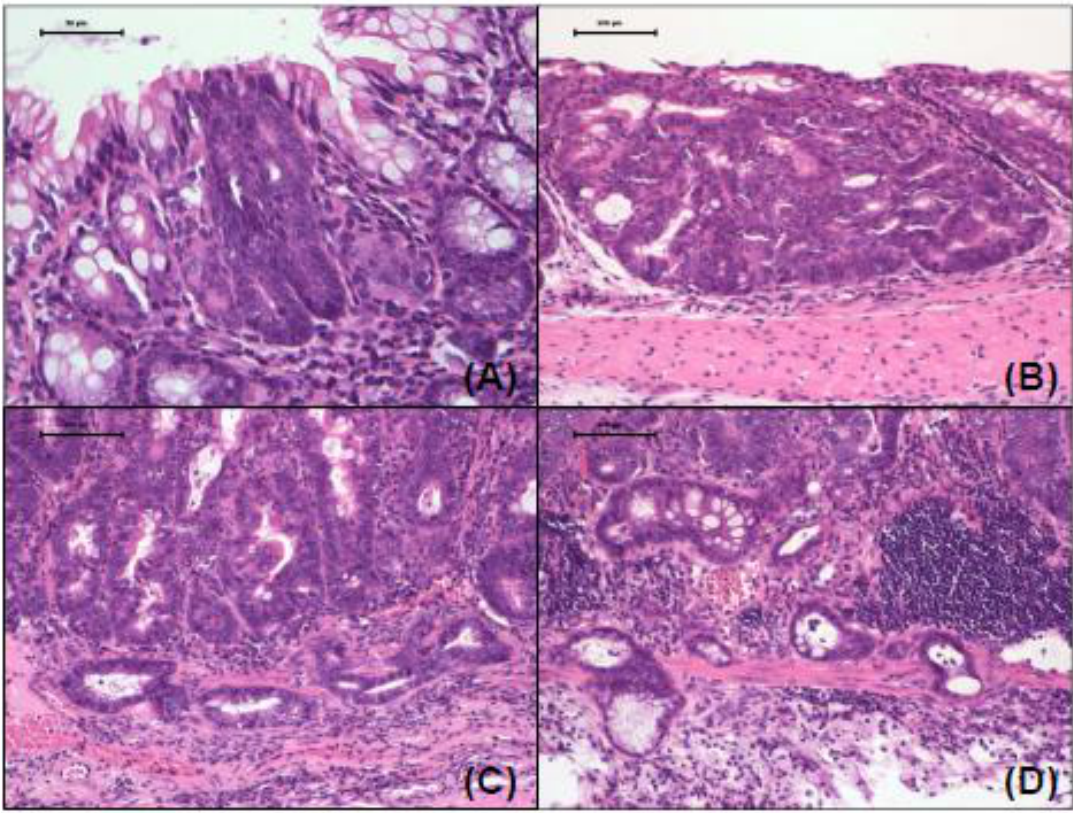
Figure 1. Representative images of proliferation colorectal lesions induced by AOM and DSS. ( A ) high grade dysplasia; ( B ) tubular adenoma; ( C ) adenocarcinoma without invasion; and ( D ) adenocarcinoma with invasion. H & E stain, 400×. Table 1. Incidences and multiplicities of colonic lesions in all groups (18-week experiment).